Question: Based on the figure, does the quantity rise or fall?
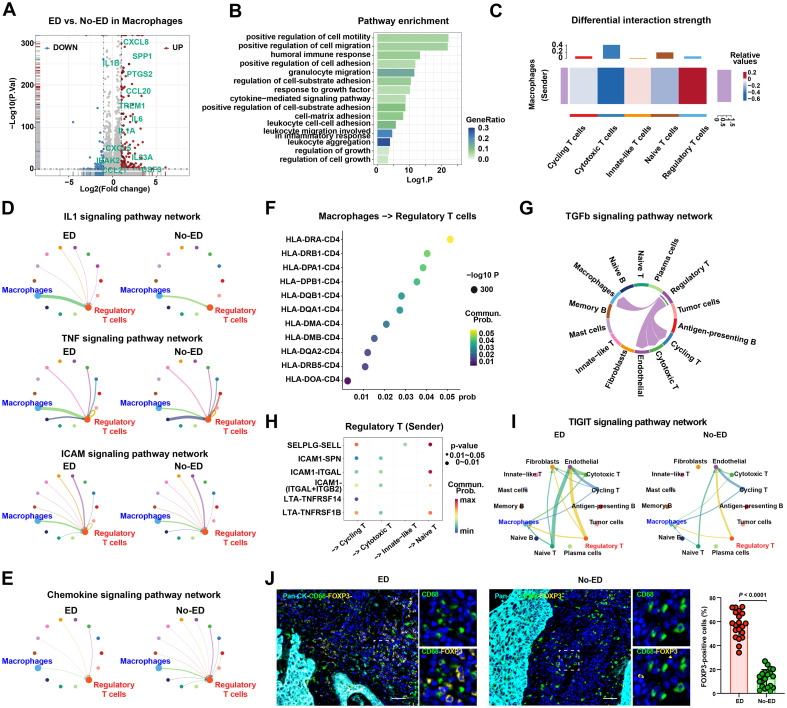
Answer: increasing